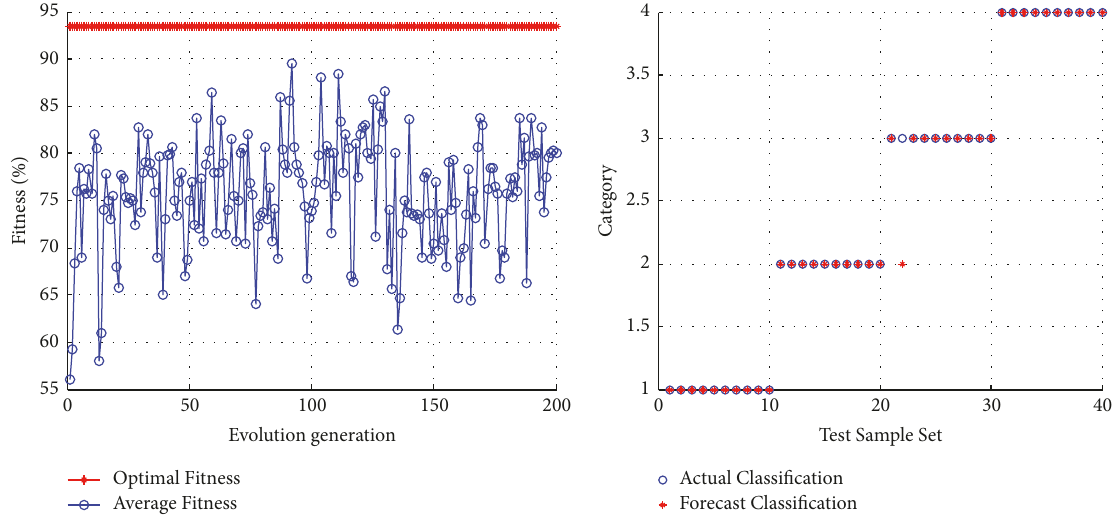
Figure 16: Classification training and test results based on